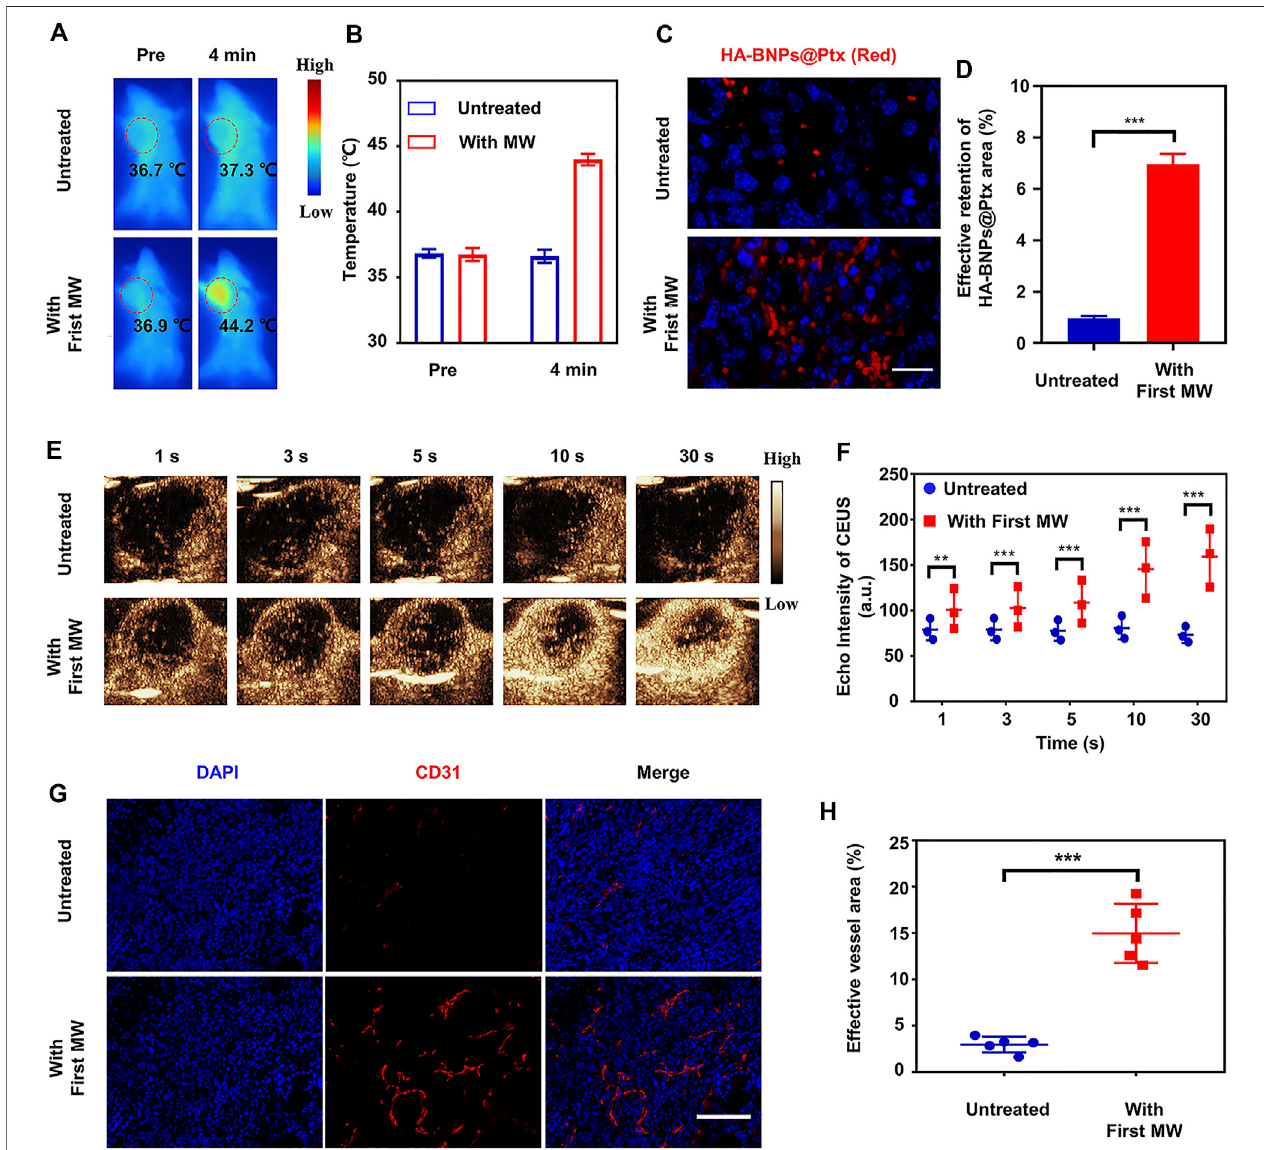
FIGURE6| Invivo mildhyperthermiaeffectsonnanoparticleuptakeandretention,intratumoral fl ow,andtumorvasculatureon4T1breasttumor-bearingmice. (A) RepresentativeIRthermalimagingofmicewithorwithoutMWirradiation(0.8 Wcm − 2 ,4 min). (B) AveragetumortemperaturebeforeandafterMWirradiation( n (cid:2) 3). (C) Representative fl uorescenceimagesofuptake/retentionofDiI-HA-BNPs@Ptxintumor-bearingmiceuntreatedandtreatedwithMWirradiation.Imageswereobtainedat 24 h after the treatment. (D) DiI-HA-BNPs@Ptx quantitative analysis of excised tumors collected from mice 24 h after treatment ( n (cid:2) 3). (E) In vivo contrast- enhanced ultrasound images obtained at different time-points after injection of microbubble contrast agent SonoVue TM . (F) Increased intratumoral perfusion was con fi rmed by quantifying contrast-enhanced echo intensity of MW-treated and untreated 4T1 tumors ( n (cid:2) 3). (G) Immuno fl uorescence expression of CD31 showed vascular dilation or opening within tumors, which was consistent with CEUS imaging fi nding. (H) Compared with untreated 4T1 tumor, the area of tumor blood vessels increased four times after MW irradiation. Scale bars represent 50 μ m. The data are presented as mean ± SD ( n (cid:2) 5, ** p < 0.01, *** p < 0.001).